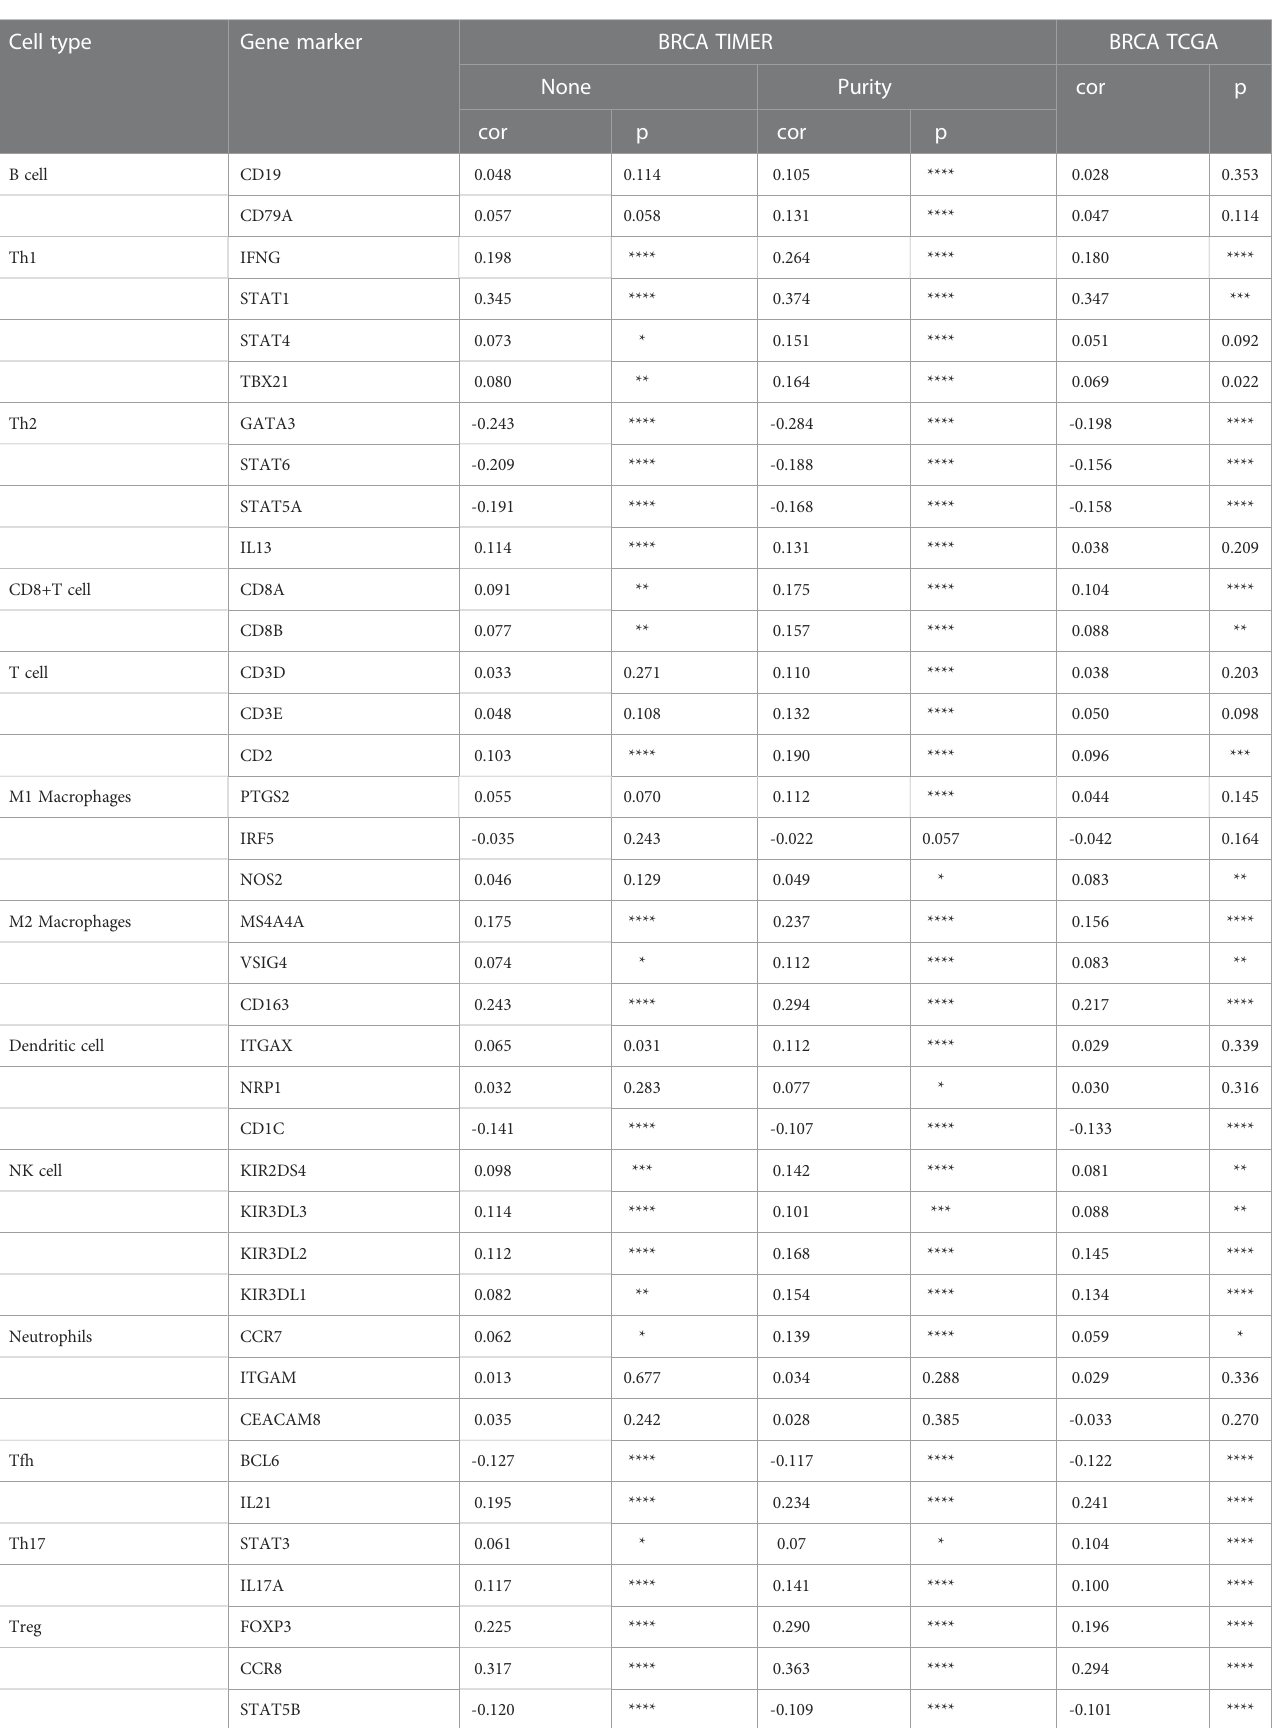
TABLE 1 Correlation analysis between MTHFD2 and immune biomarkers by TIMER and TCGA databases. Cell